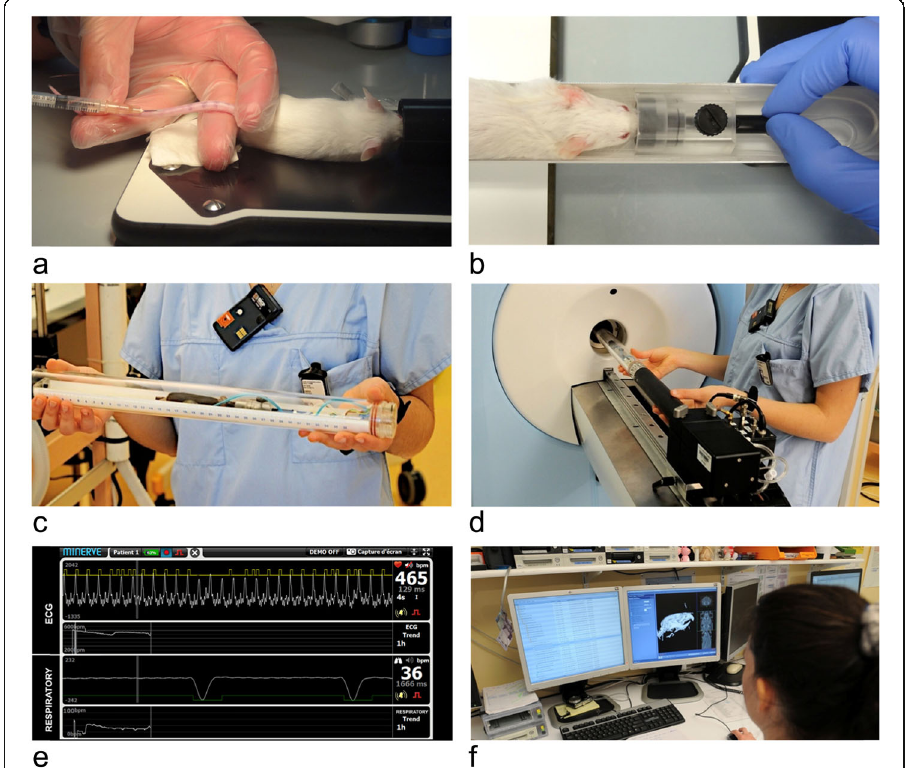
Fig. 5 Examples of procedures performed by NMTs and radiographers in a preclinical department. Intravenous injection ( a ), animal anaesthesia and positioning ( b ) in an imaging cell ( c ). Imaging cell docking ( d ), animal monitoring ( e ), data acquisition, archiving, and post-processing ( f